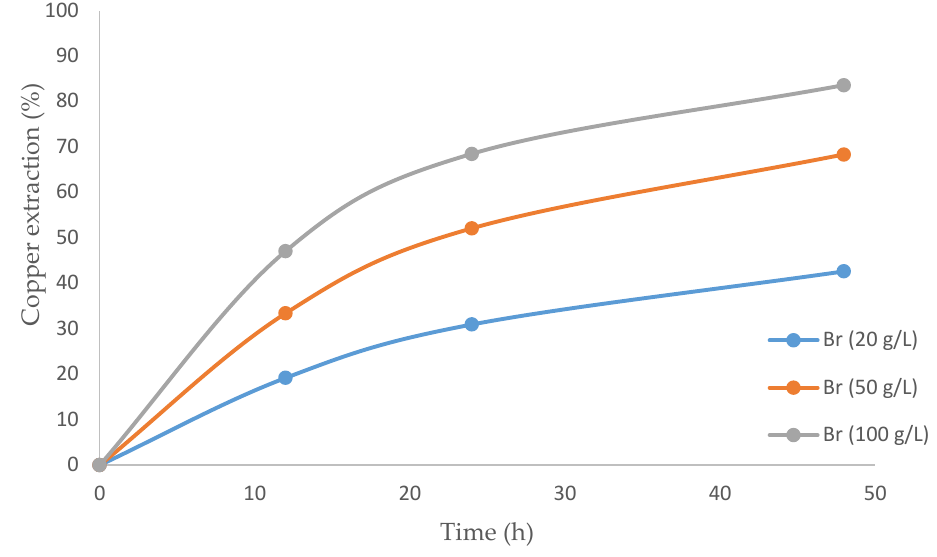
Figure 5. Graph of the copper extraction percentage over time using an ionic liquid and varying concentrations of bromide.